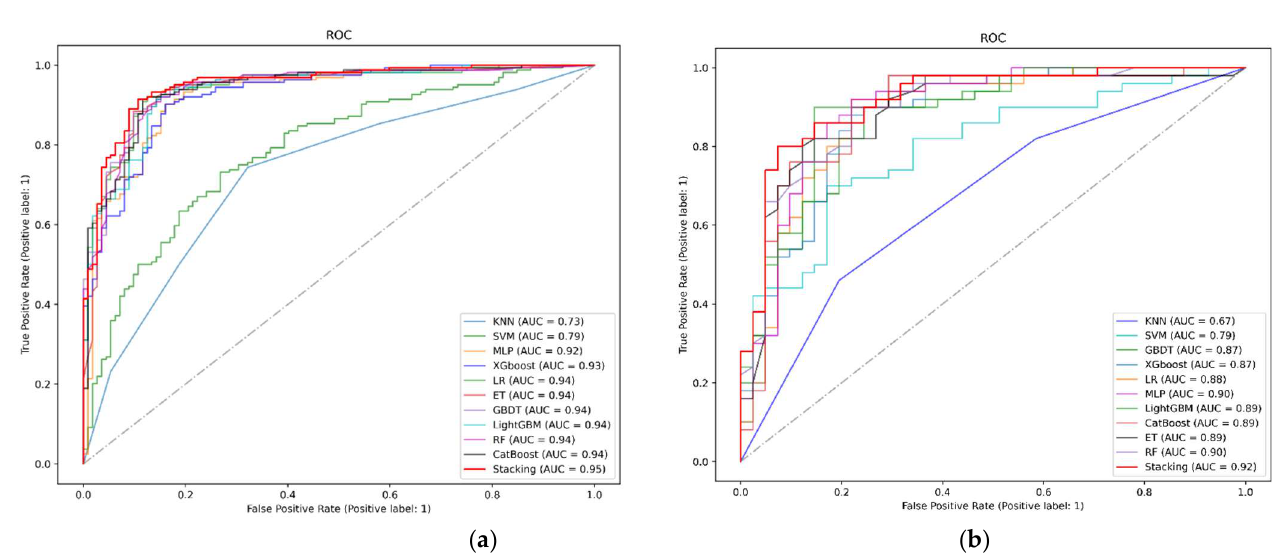
Figure 7. ( a ) ROC curve on Heart Dataset. ( b ) ROC curve on Heart Attack Dataset.